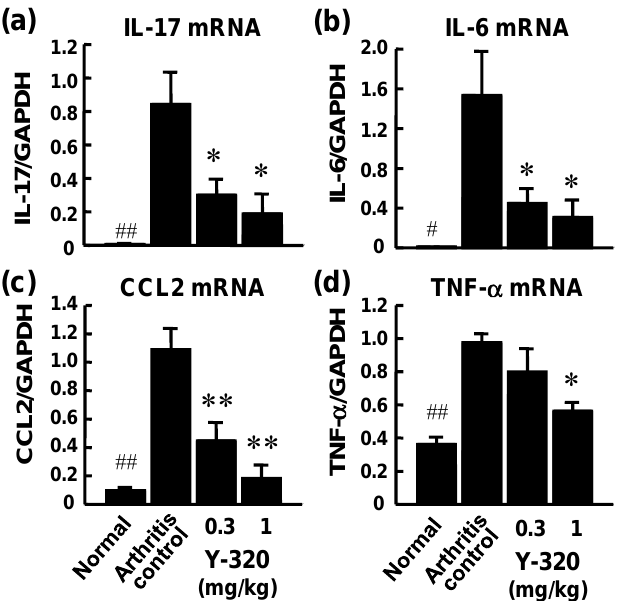
Figure 4. The mRNA expressions of pro-inflammatory cytokines in the arthritic joints of CIA mice treated with Y-320. Y-320 was administered orally to mice from the day of primary immunization for 6 weeks. ( a ) IL-17 mRNA; ( b ) IL-6 mRNA; ( c ) CCL2 mRNA; ( d ) TNF- α mRNA. Results were expressed as the mean ± SEM of 4 mice. * p <